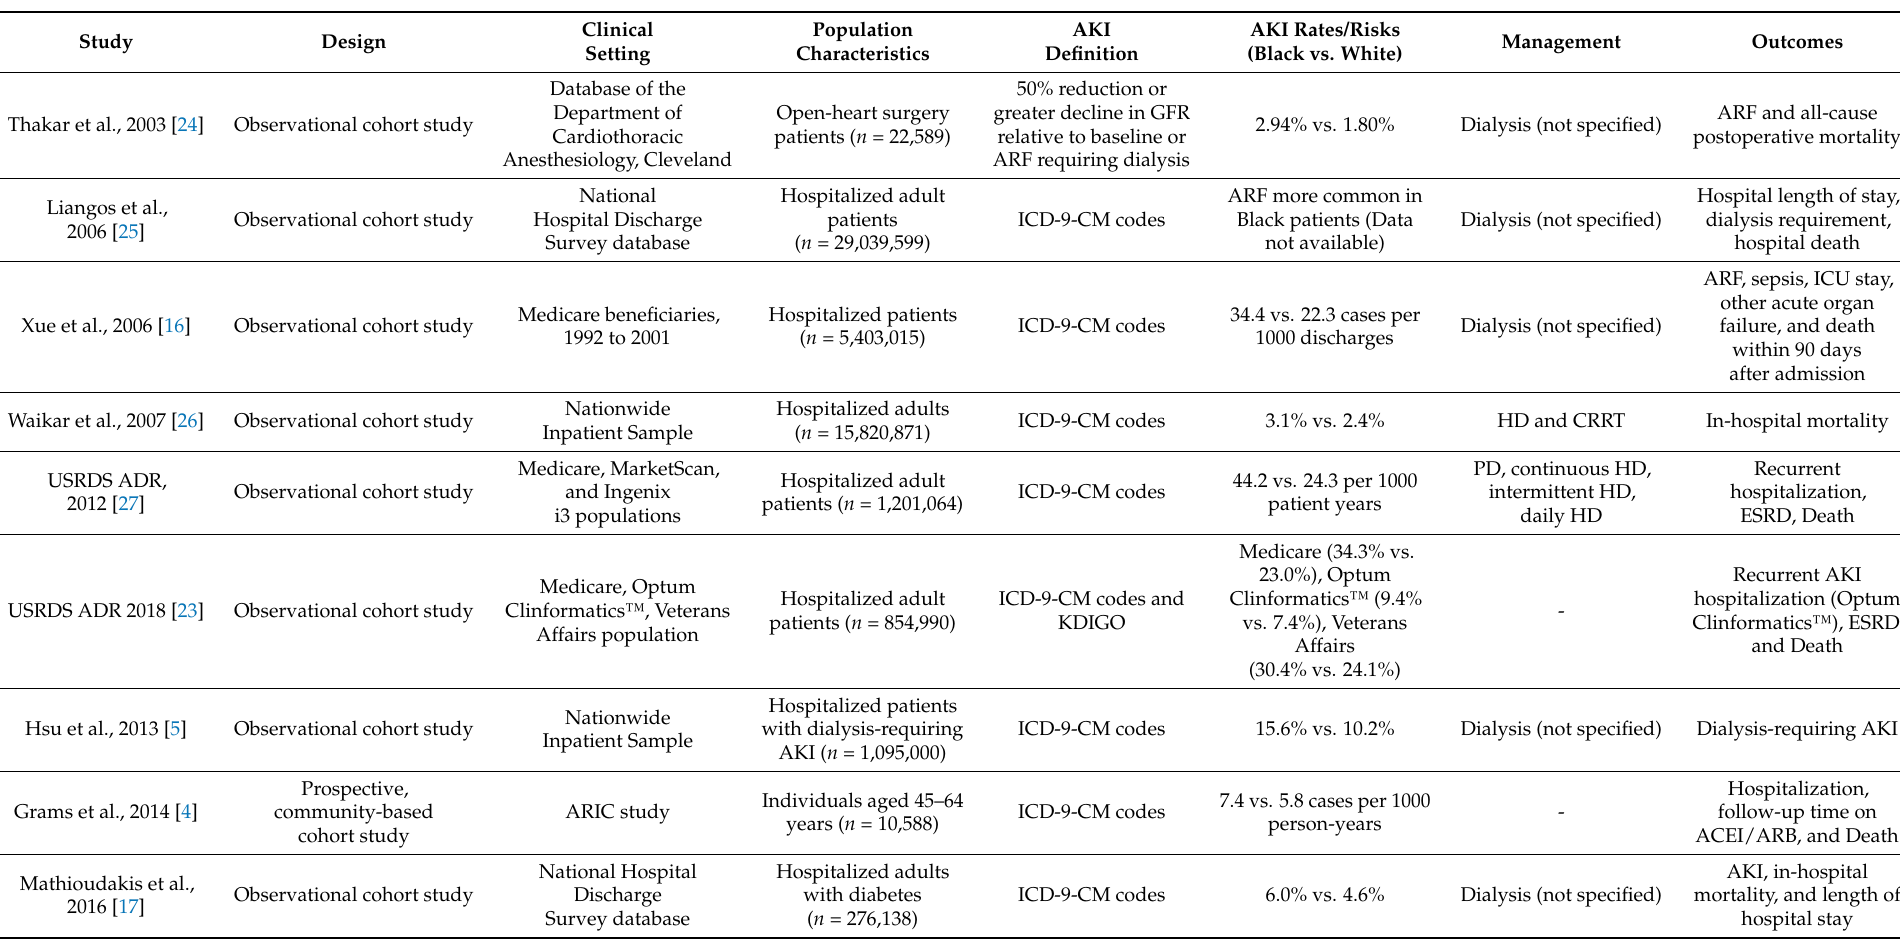
Table 1. Studies summarizing incidence, management, and outcomes of AKI in Black and White